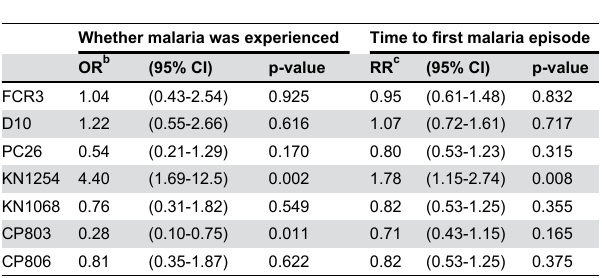
Table 5. Multivariate regression analysis: effects of parasite strain-specific IgG responses on malaria risk. a